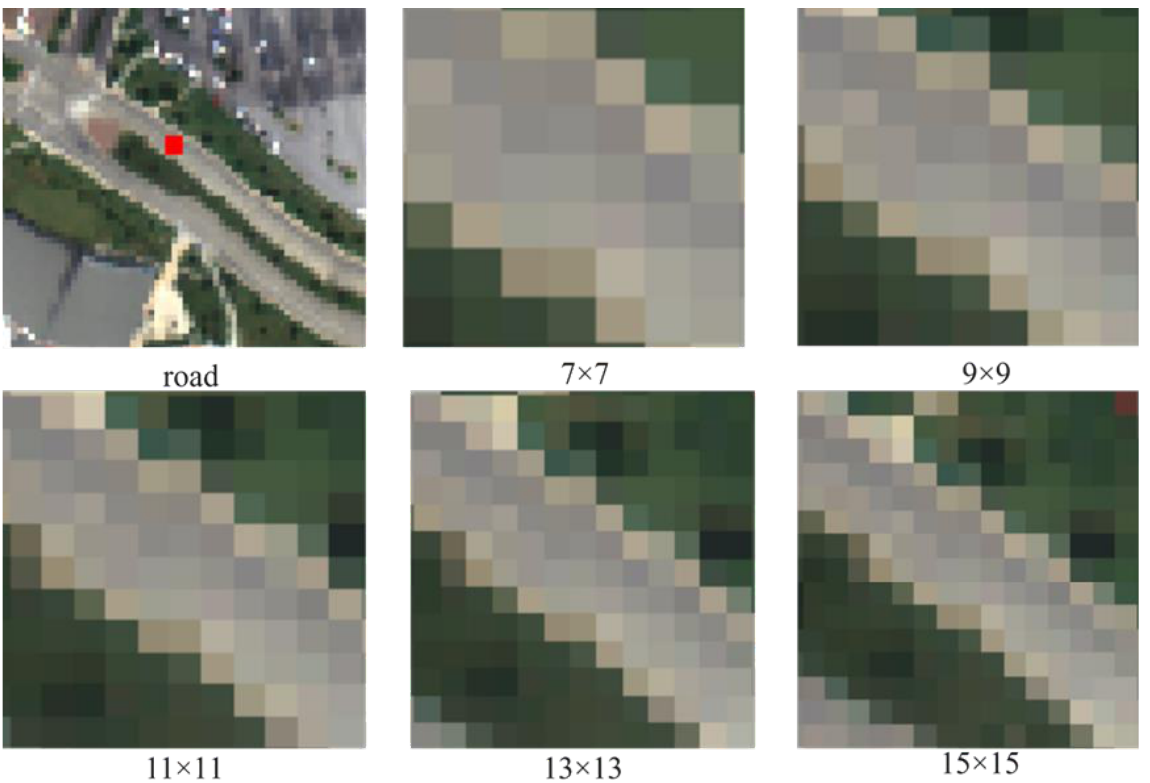
Figure 14. Sample of road with different input sizes on the Houston dataset.